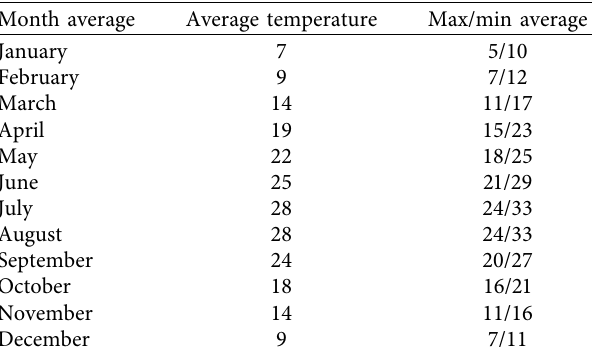
Table 3: Chongqing’s monthly temperature